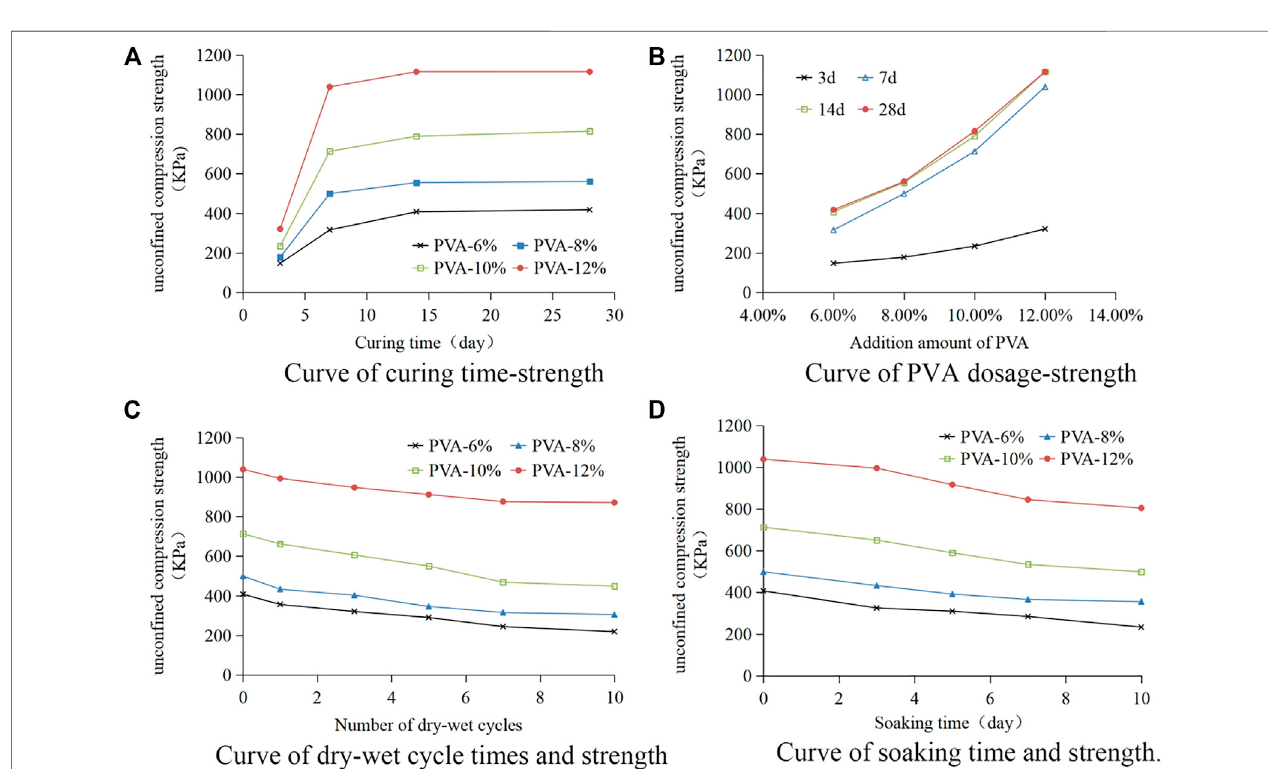
FIGURE6| Uncon fi nedcompressivestrengthunderdifferentconditions: (A) curingtime-strength. (B) PVAdosage-strength. (C) dry-wetcycletimesandstrength. (D) soaking time and strength.